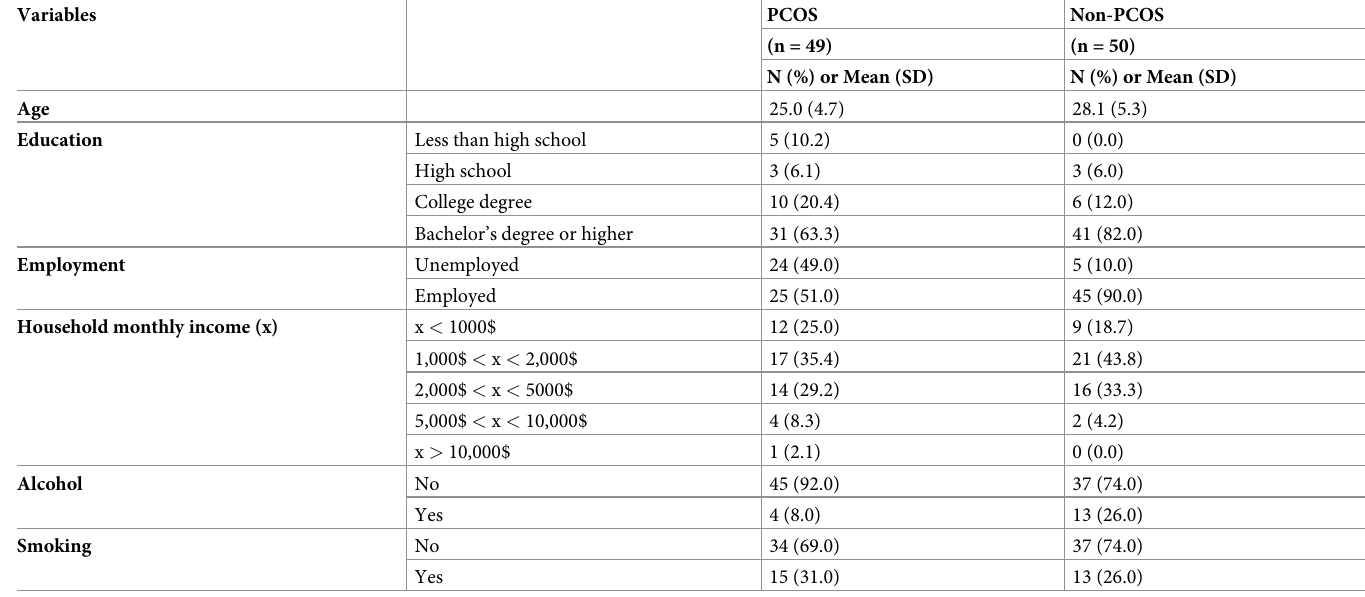
Table 1. Distribution of PCOS and non-PCOS groups with respect to their individual characteristics.